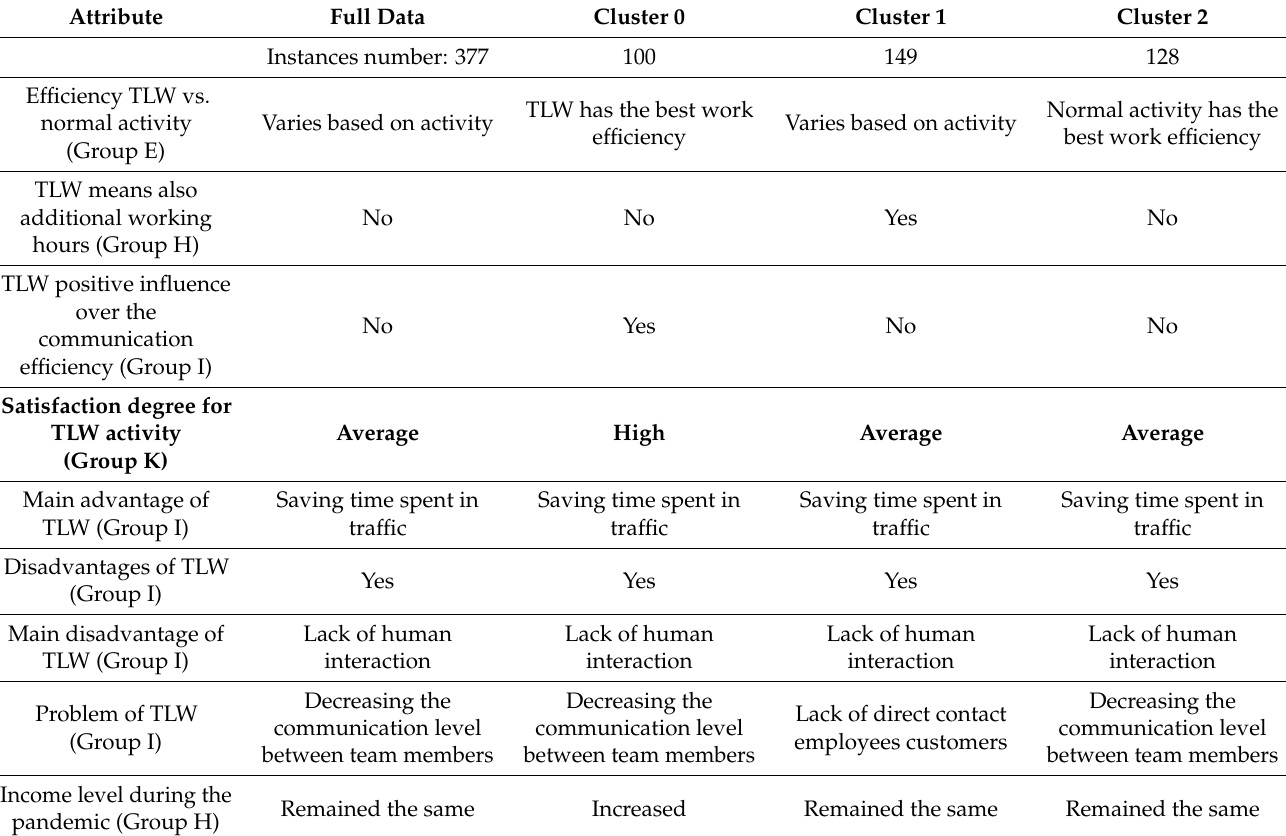
Table 4. Table 4. Cluster analysis of work